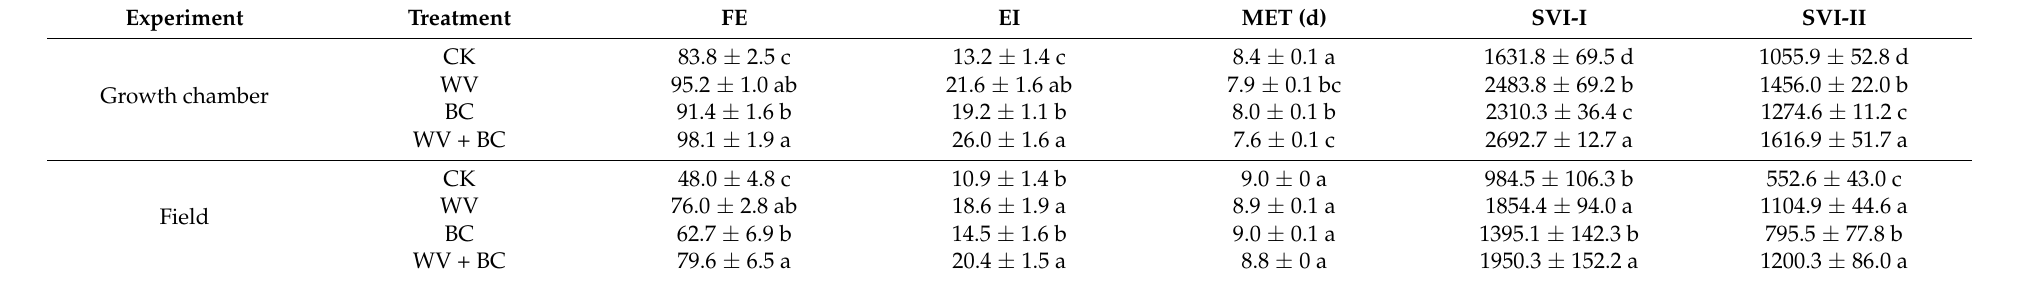
Table 3. Emergence characteristics of different seed treatments of WDR under dry direct-seeded